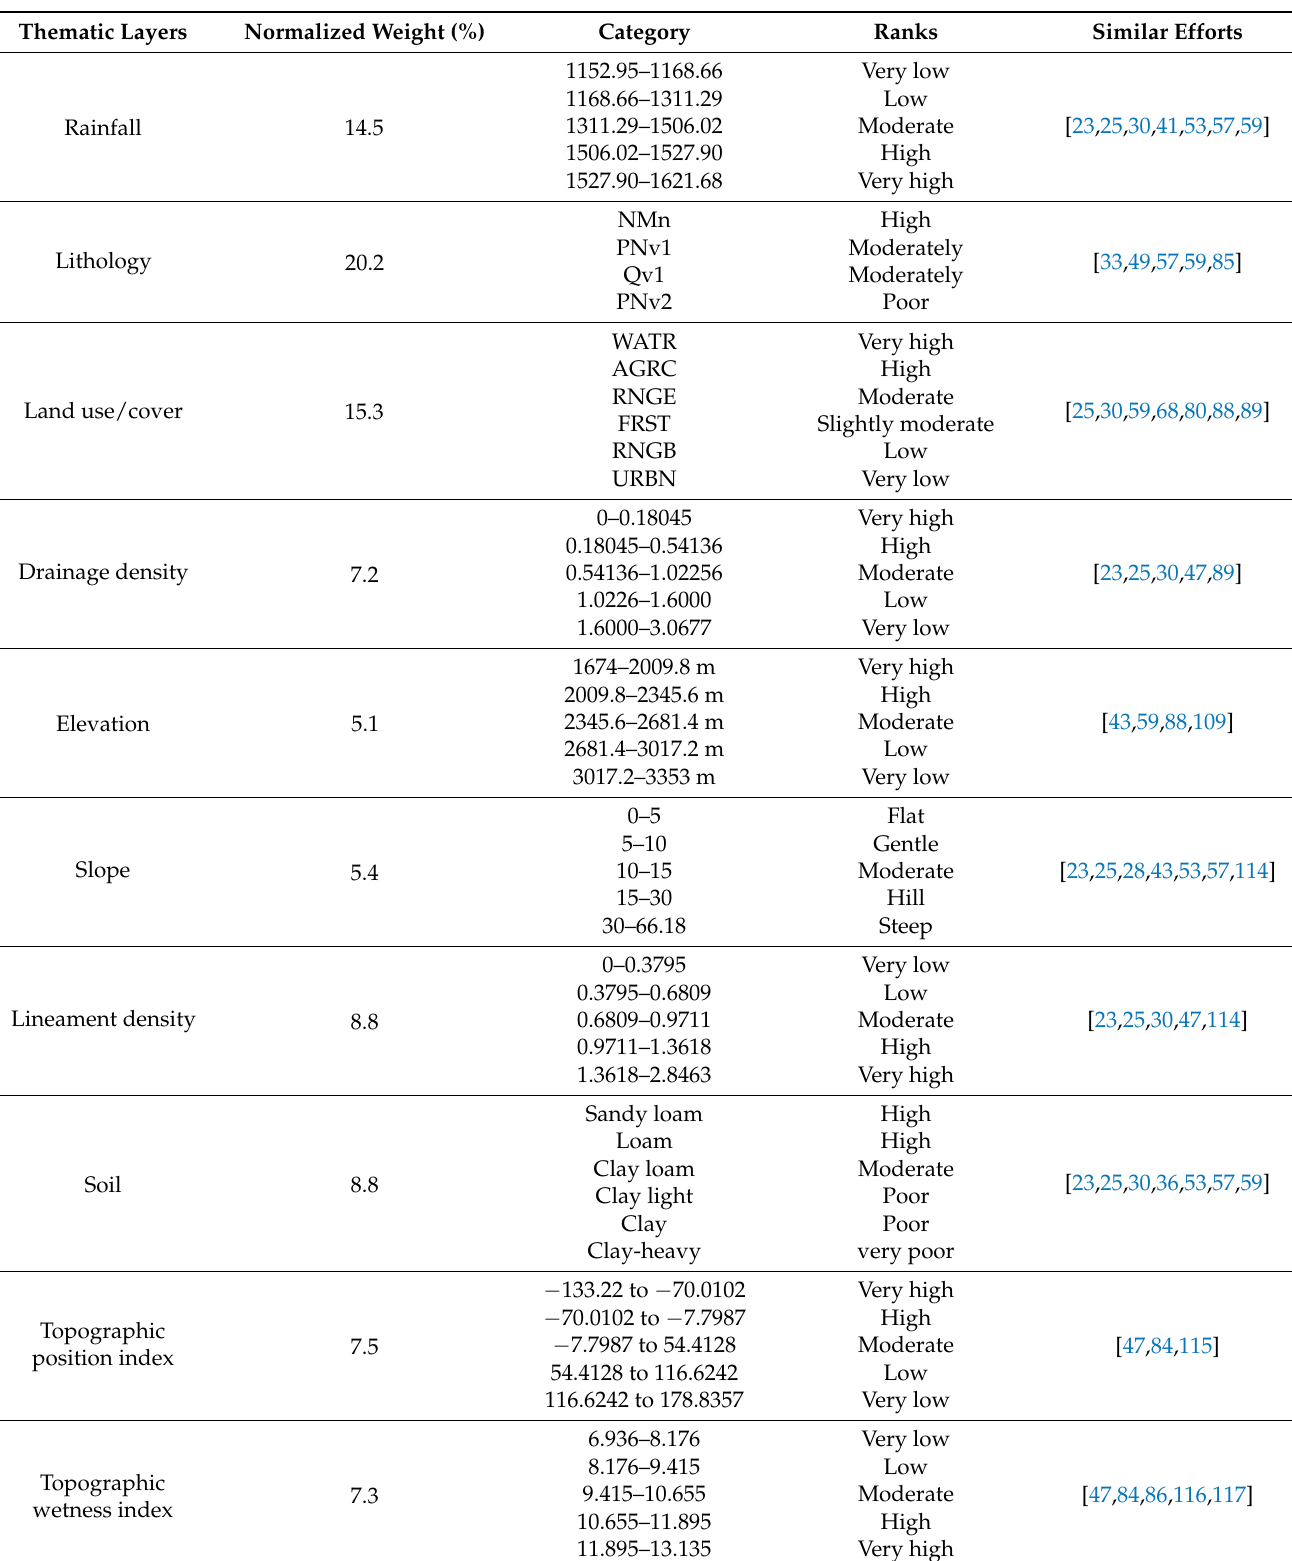
Table 3. Normalized weights for proxy layers as suitable for groundwater